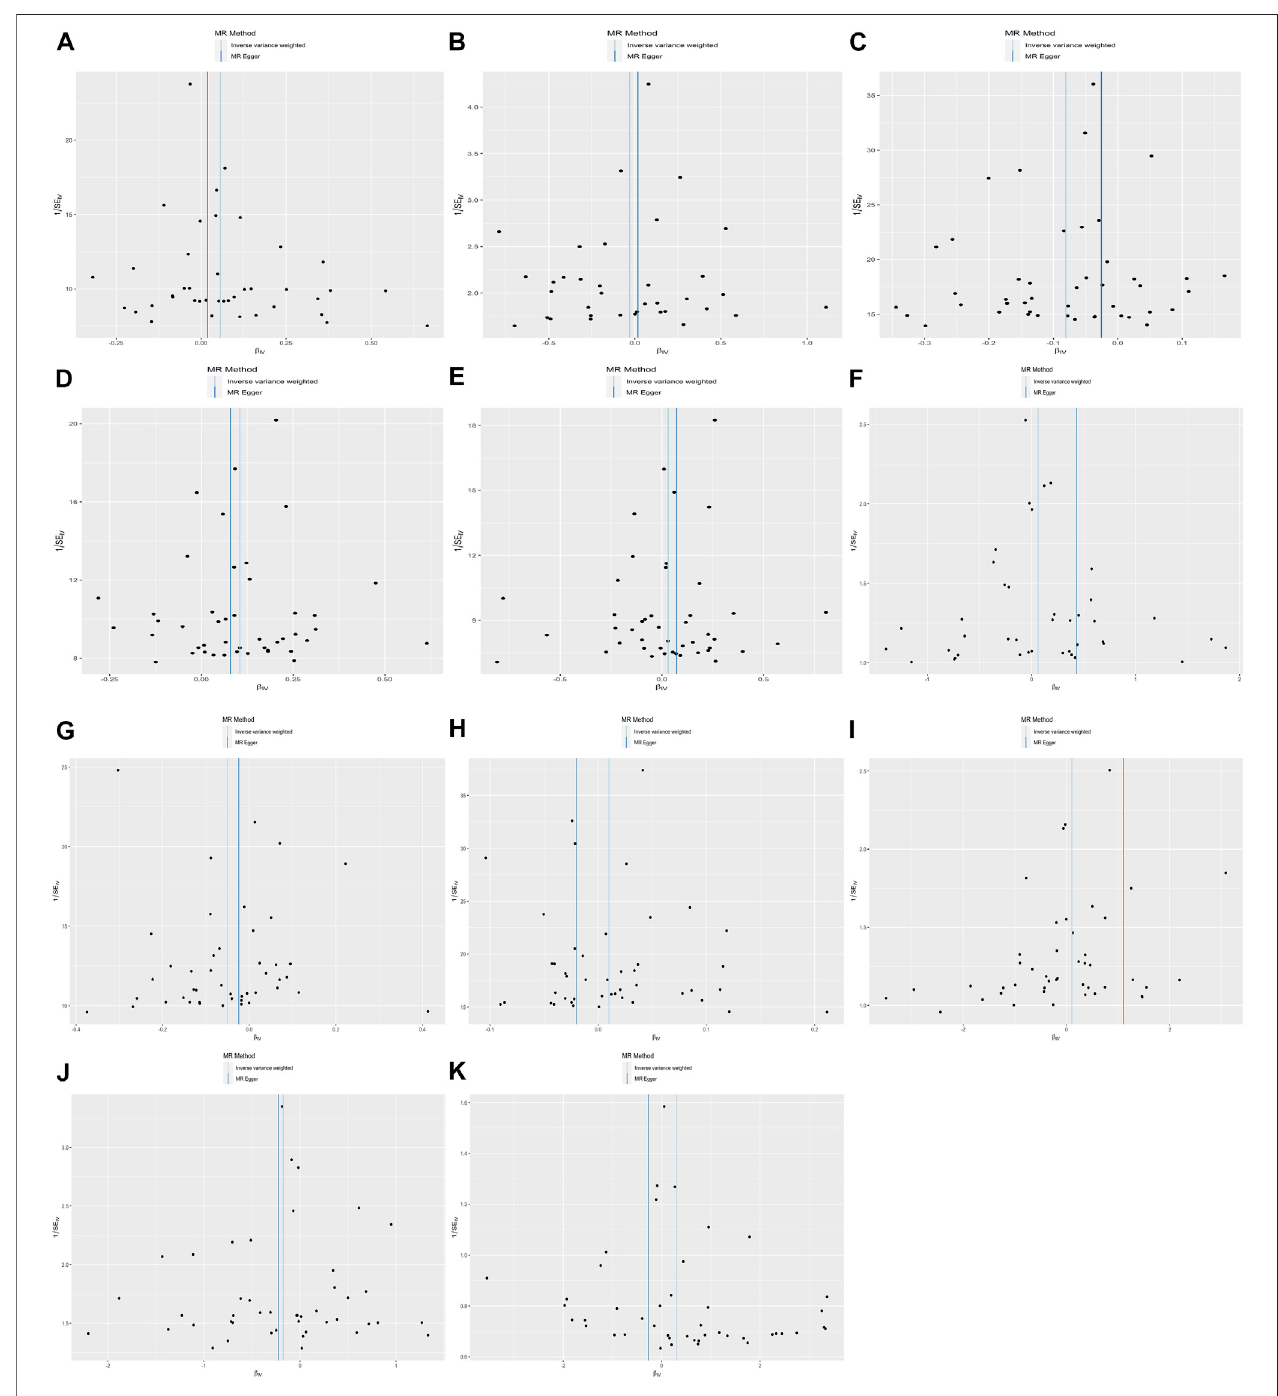
FIGURE 5 | The results of the funnel